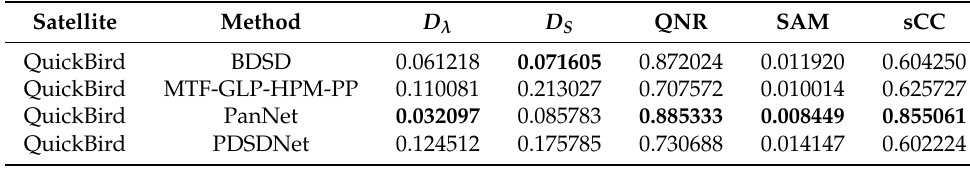
Figure 8. Visualization of local details of QuickBird test images: ( a ) PAN; ( b ) MS; ( c ) BDSD; ( d ) MTF- GLP-HPM-PP; ( e ) PanNet; ( f ) PDSDNet. Table 5. Quality indexes of QuickBird test images.